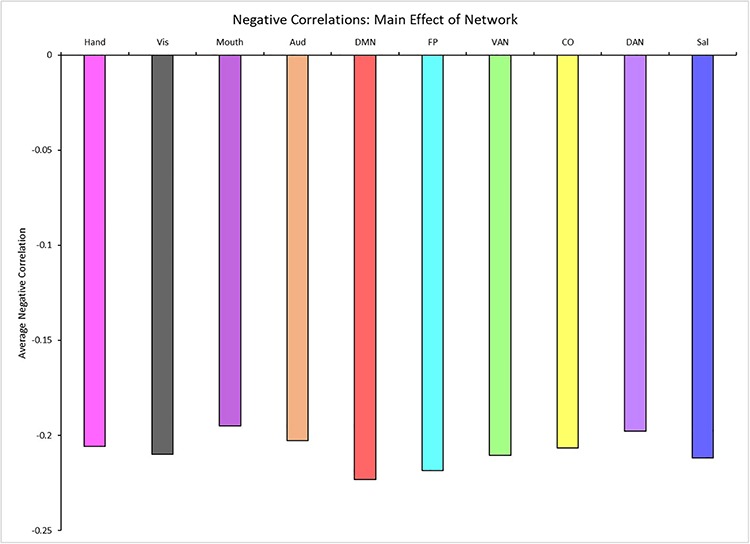
Main effect of network showing the average negative between-network correlation for each network (for significant differences see Table 4). Network colors correspond to their color assignments in Figures 1–3.